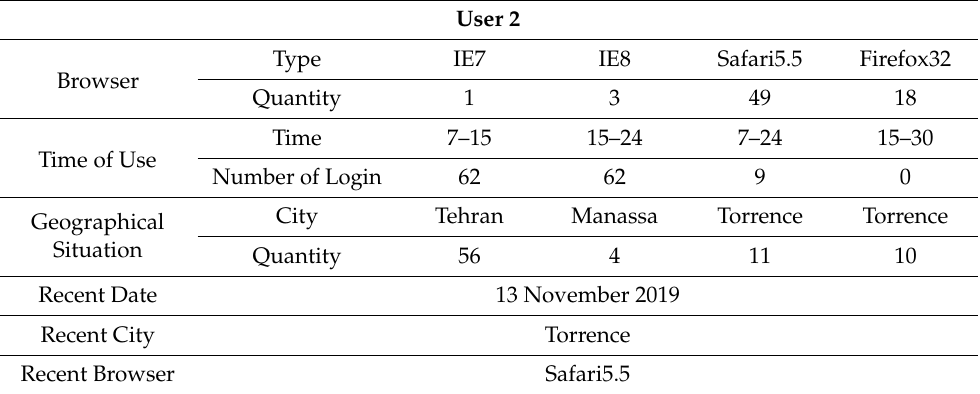
Table 13. Profile of User 2 (source: research analysis).